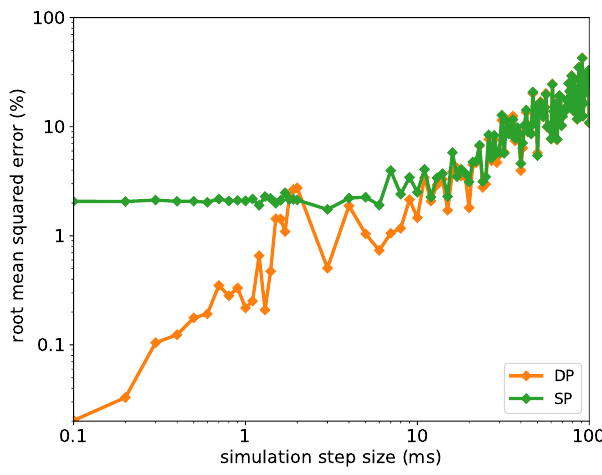
Figure 8. RMSE of the simulation results of the SG unit with classic inertia depending on the simulation step